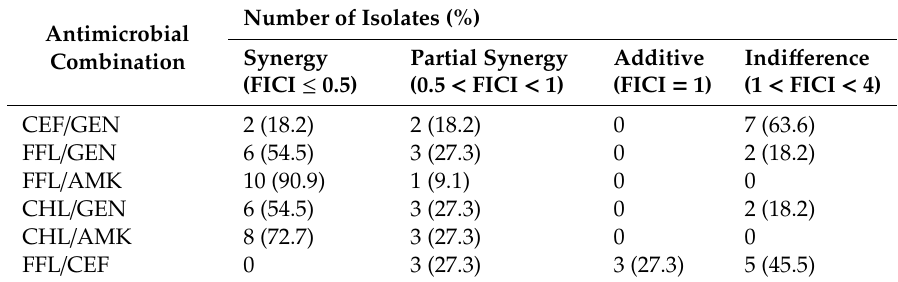
Table 2. In vitro inhibitory activity of di ff erent antimicrobial combinations against multidrug-resistant E. coli isolates.